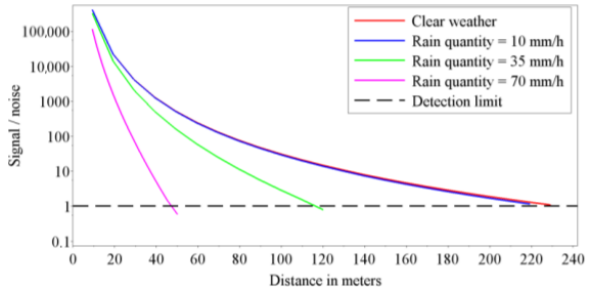
Figure 10. Variation of the signal/noise ratio as a function of the rain rate and distance between LiDAR and target for a rain droplet radius equal to 3